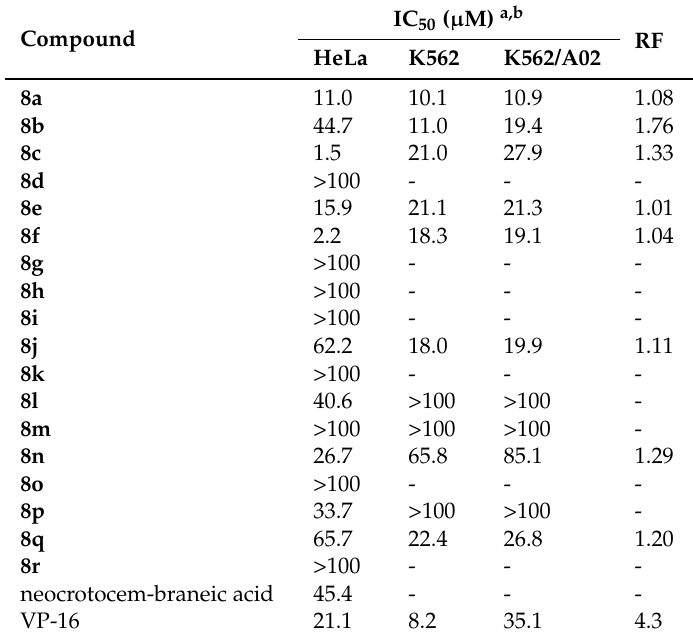
Table 1. Cytotoxic activities of the synthesized derivatives against Hela, K562 and K562/A02. IC 50 ( µ M) Compound